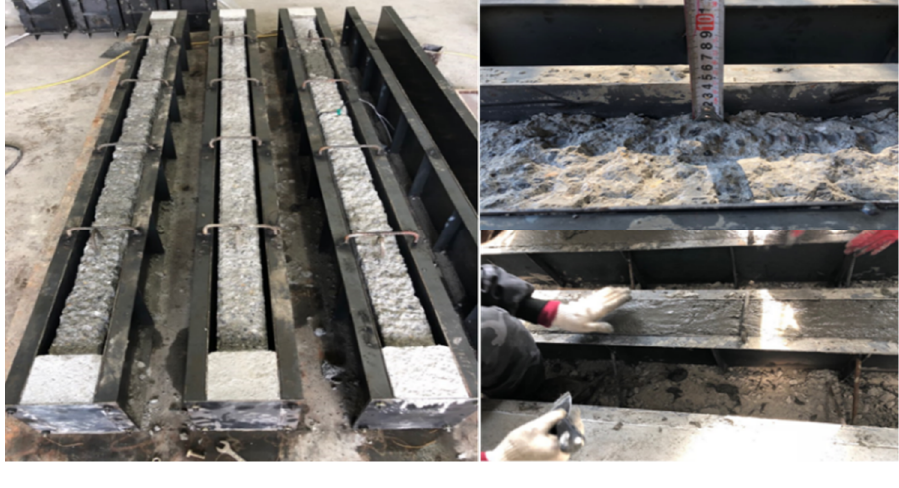
Figure 4. Test set-up of beam flexural strength test. 3. Results and Discussion 3.1. Slant Shear Strength of the Interface 3.1.1. Slant Shear Strength and Failure Mode of Composite NSC and NSHSDC Specimens Table 7 presents the slant shear test results at 28 days. The failure mode of the slant shear test specimens was divided into interface sliding failure, near interface concrete cracking, and total concrete crushing according to experimental observation [23–25]. Compressive strength ( f ck, s ) of composite specimens was calculated under maximum load divided by the section area base on the